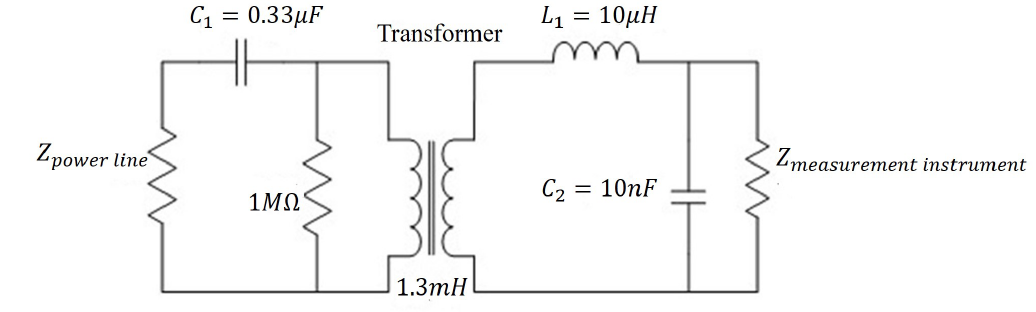
Figure 2. Coupling filter